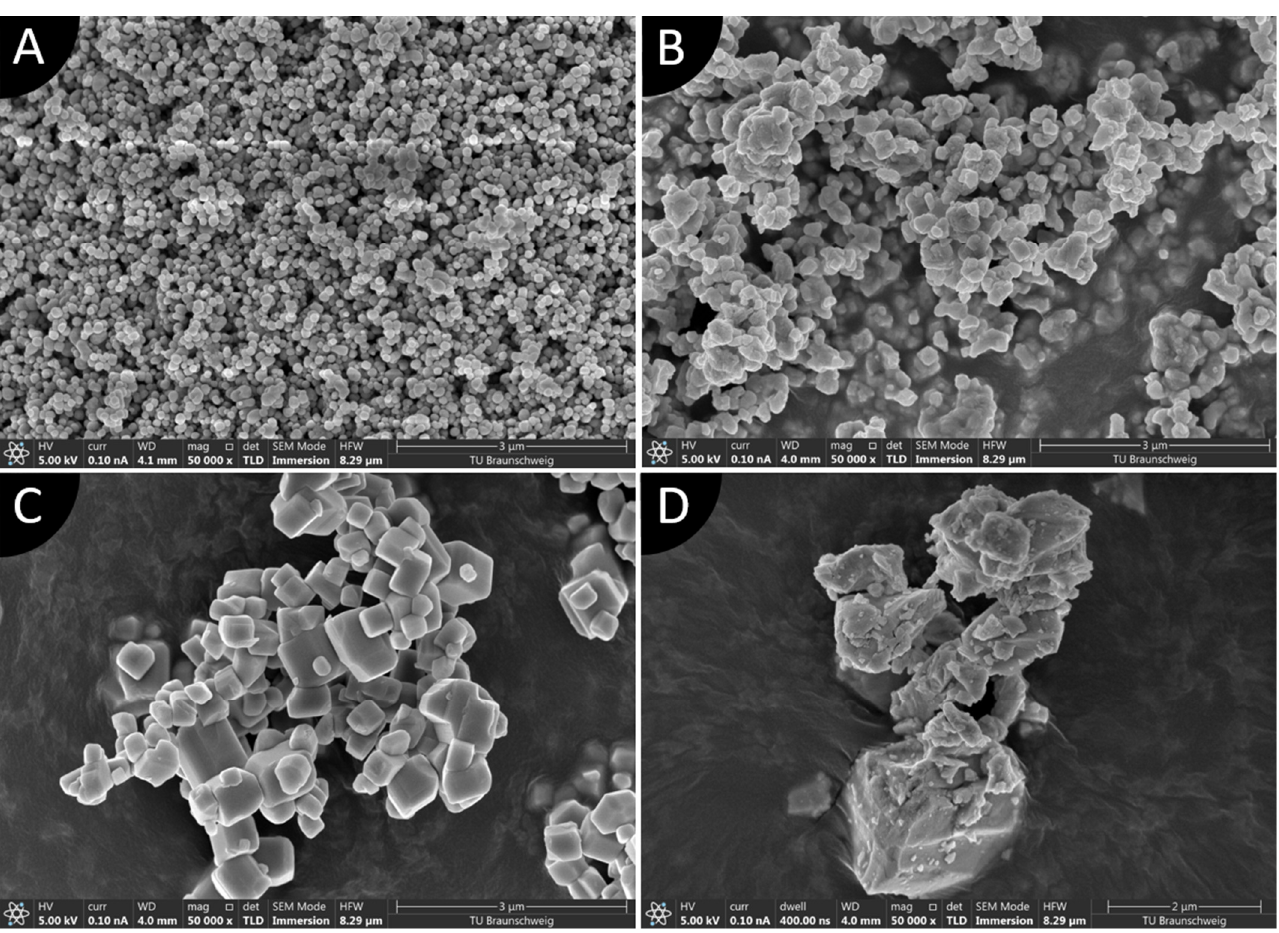
Figure 1. SEM images of piezoelectric ceramic particles used in this study (magnification ×50,000): ( A ) BTO; ( B ) KNN7; ( C ) KNN3.5; ( D ) PZT.